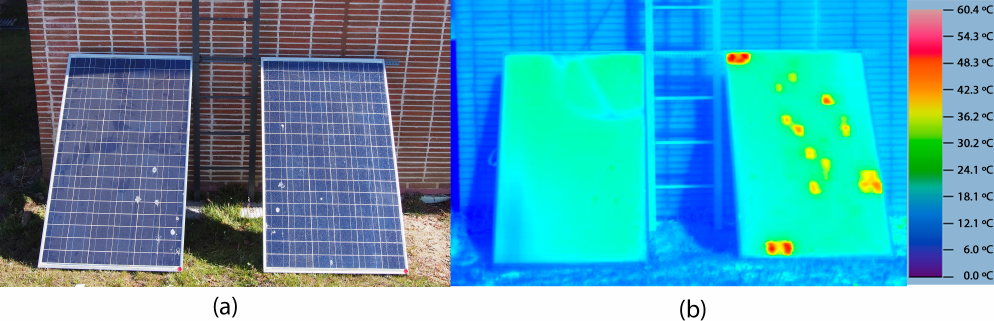
Figure 1. Example of the images generated by the different imaging sensors used: ( a ) RGB image; and ( b ) thermographic image with thermal values represented using a color map.